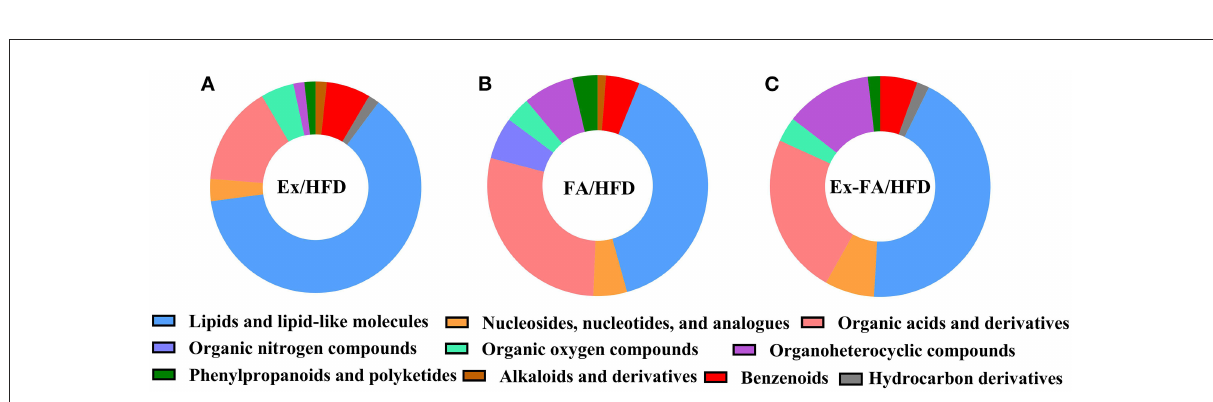
FIGURE7 HMDB classification of the differential metabolites. (A) Ex vs. HFD; (B) FA vs. HFD; (C) Ex-FA vs. HFD. HFD, high-fat diet group (model); Ex, high-fat diet with exercise; FA, high-fat diet with ferulic acid; Ex-FA, high-fat diet with exercise and ferulic acid.